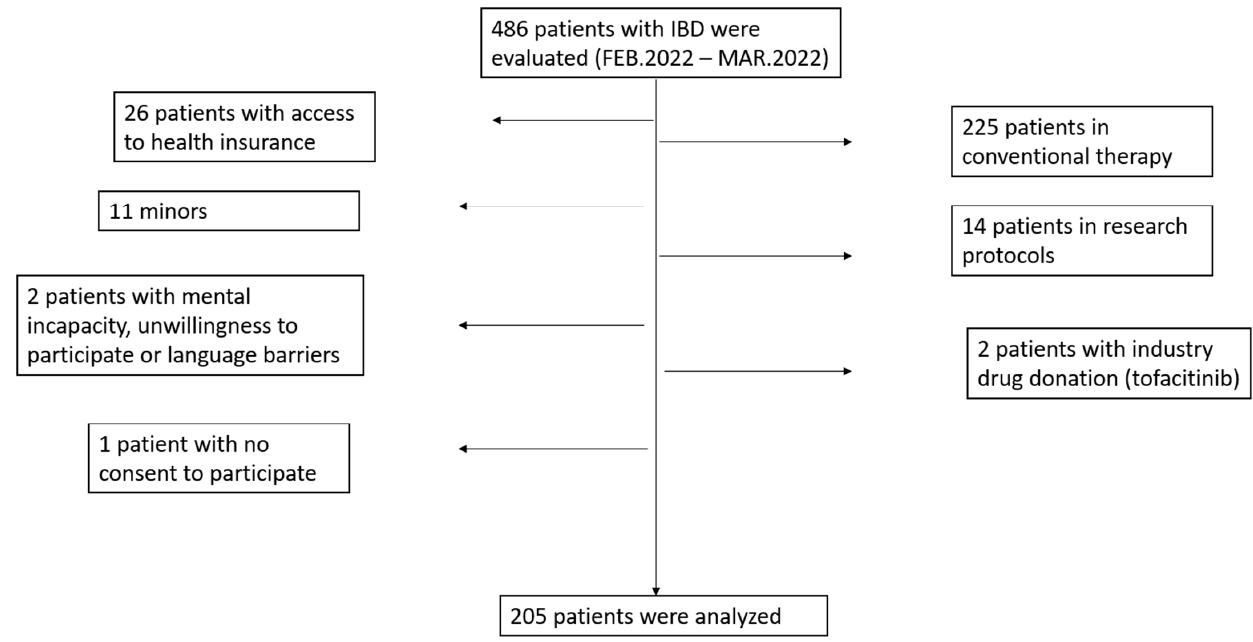
Figure 1. Flow chart of patients with IBD included in this study.